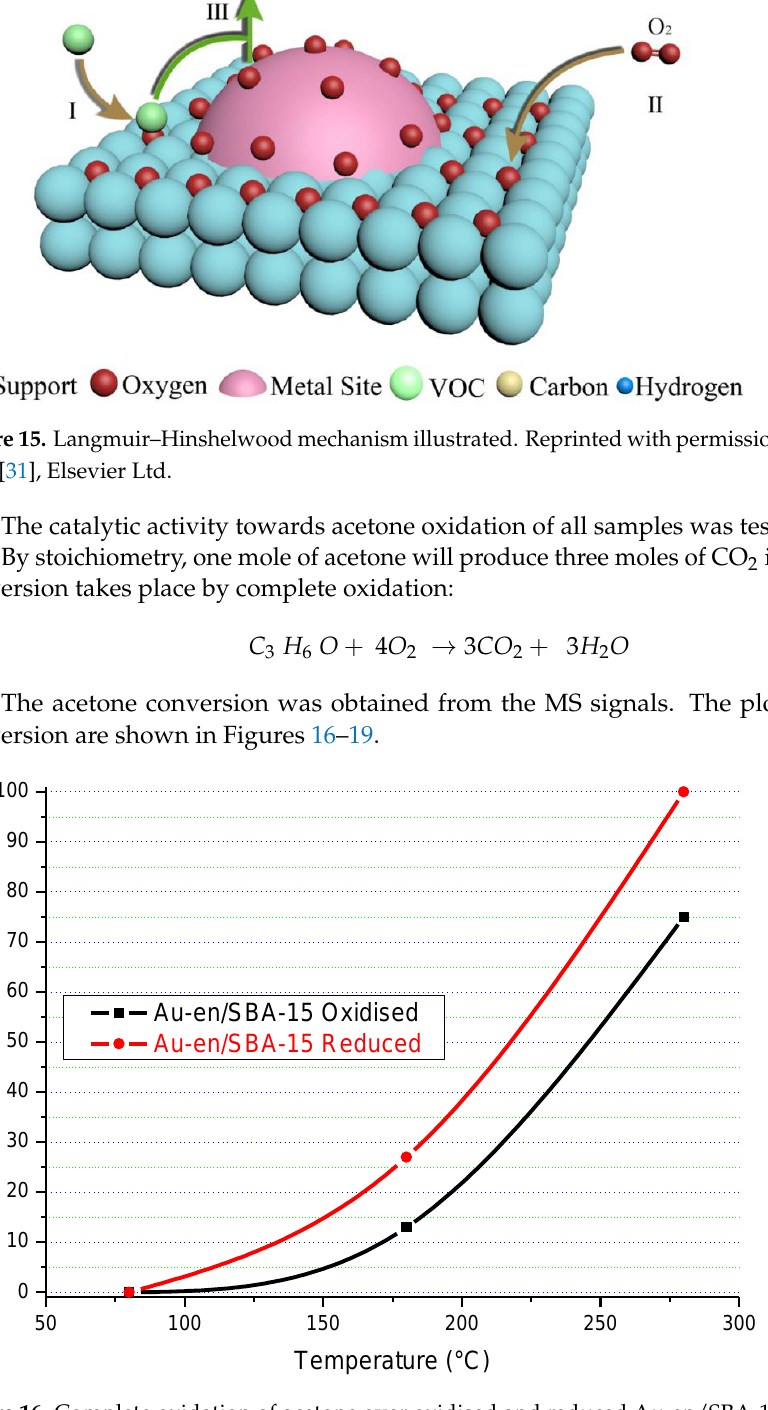
Figure 14. Eley – Rideal mechanism illustrated. Reprinted with permission from Mu et al., 2021,[31] Elsevier Ltd.